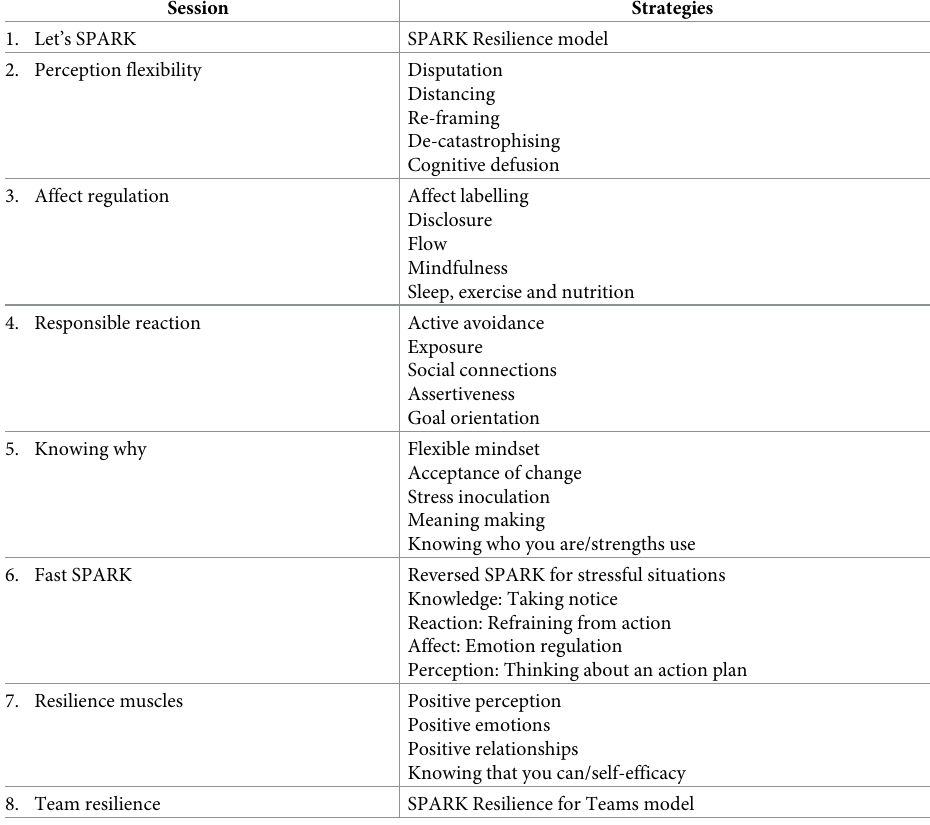
Table 1. SPARK Resilience in the workplace sessions and associated